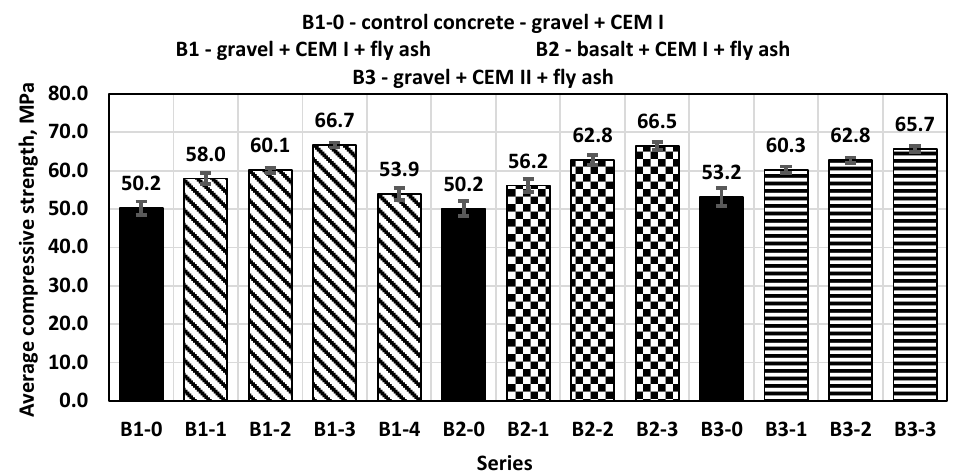
Figure 5. Average compressive strength after 56 days.